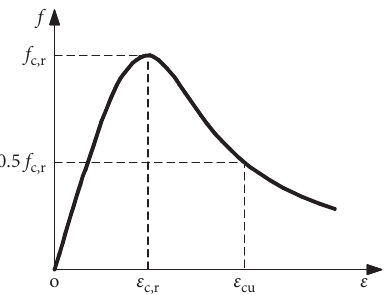
Figure 7: Schematic diagram of concrete material